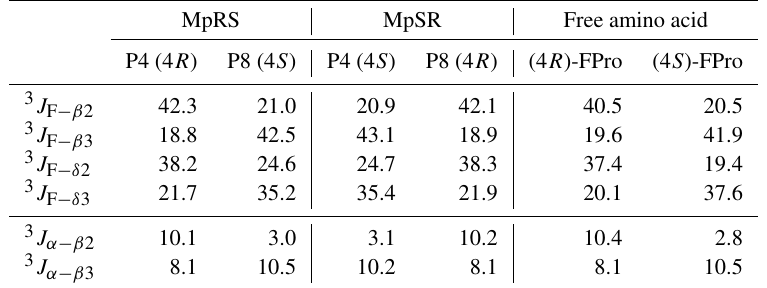
Table 2. Comparison of the scalar coupling constants (in Hz) of (4 R )-FPro and (4 S )-FPro measured in MpRS and MpSR peptides with those reported for the free fluoroproline residues (Gerig and McLeod,